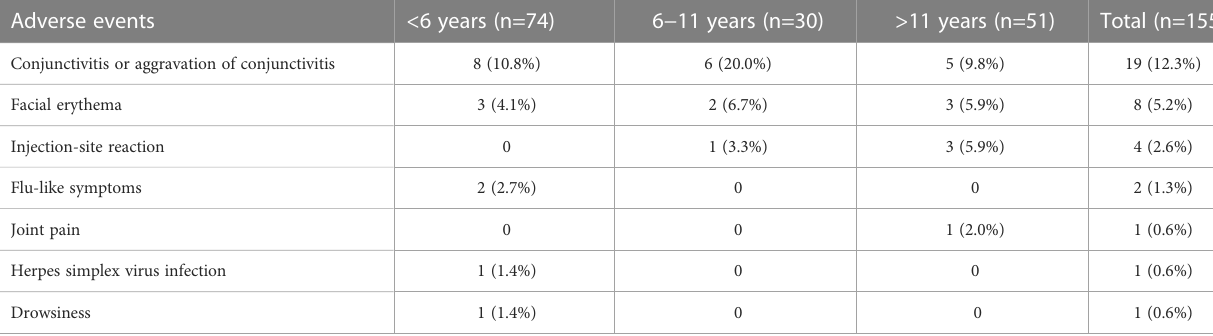
TABLE 3 Adverse events during dupilumab treatment.